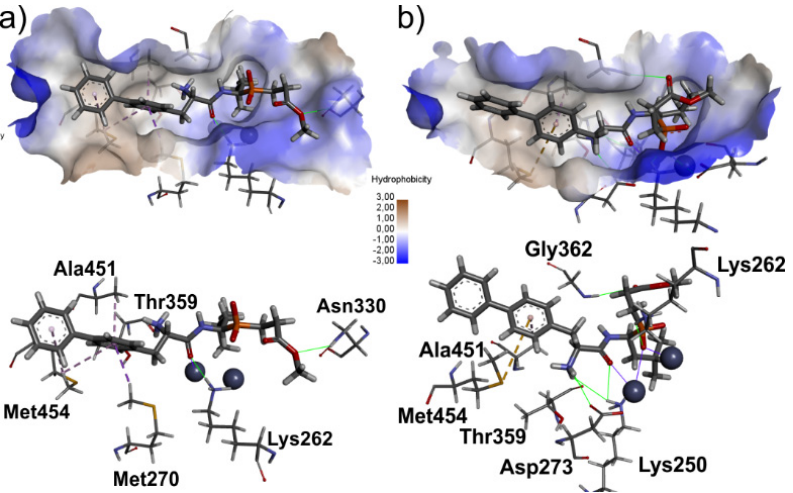
Figure 8. Modeled binding mode of ( a ) 7 -S R isomer and ( b ) 7 - SS isomer in the active center of bovine leucyl aminopeptidase (PDB: 1LCP). Amino acid residues of the inhibitor and enzyme are shown as sticks, while the zinc ions are shown as a gray sphere. Hydrogen bonds are shown as thin green lines, metal ion—coordinating moieties interaction shown as a thin blue line, aromatic π -electrons—aliphatic group, and sulfur atom shown as dashed lines. The surface of the active site is colored according to hydrophobicity.